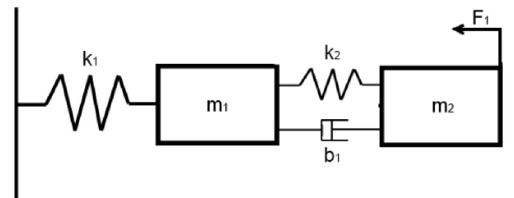
Figure 2. Example of a 2 degrees of freedom electrical cascade model created in the voltage analogy to mechanical model. Masses are represented by coils L i , springs are the capacitors C i and dampers are the resistors R i . The external forces are represented by voltages U i .